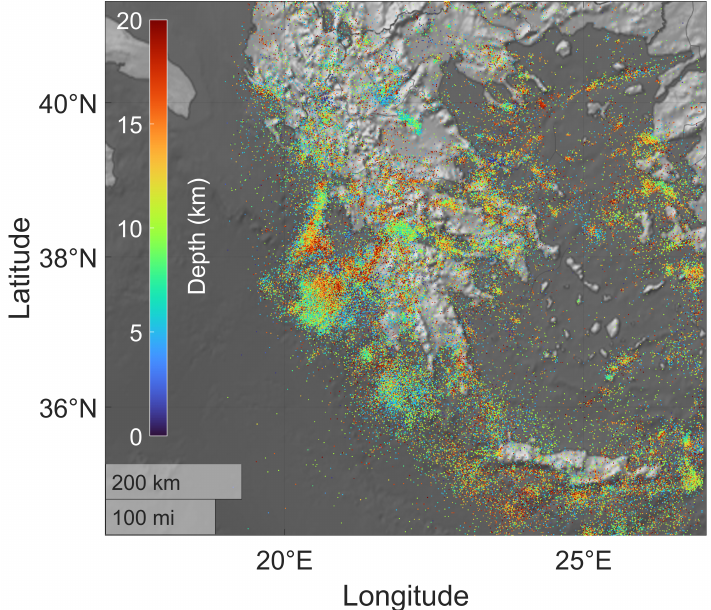
Figure 5. Map of seismicity in Greece between 1990 and 1/8/2021, M L > 2.0, NOAIG